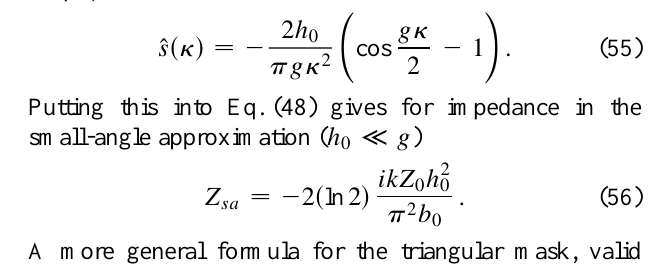
FIG. 3. Ratio of the small-angle approximation impedance (cid:90) (cid:115)(cid:97) , Eq. (52), and (cid:90) given by Eq. (53) as a function of the ellipsoid aspect ratio. shape, one finds